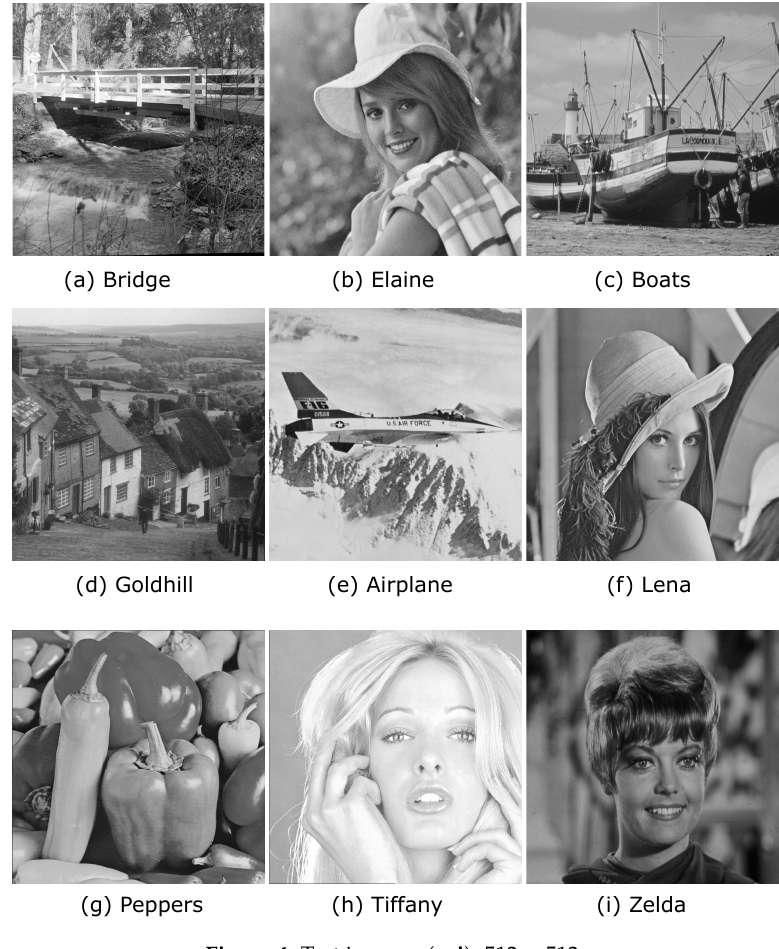
Figure 4. Test images; ( a – i ): 512 × 512. Table 3. Comparison of BTC-like schemes on PSNR, CR, and